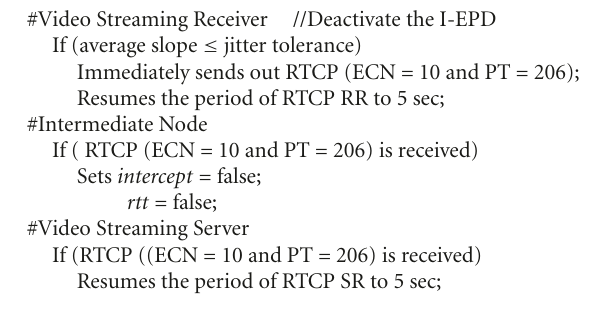
Algorithm 3: Deactivation of the I-EPD.